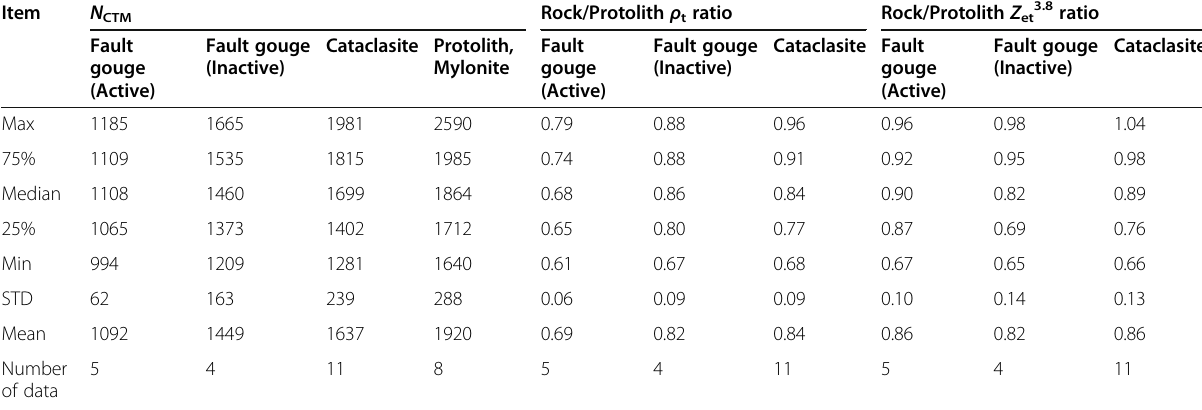
Table 6 Statistics of the determined N CTM values and rock/protolith ratios ( ρ t and Z et3.8 ) Item N CTM Rock/Protolith ρ t